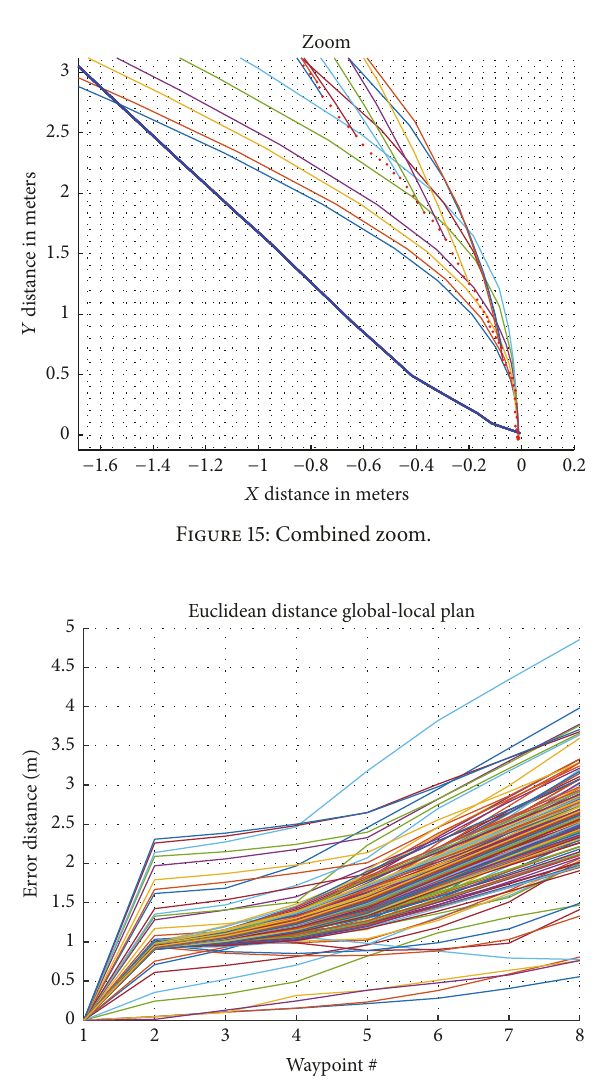
Figure 16: Error local plan, global plan.